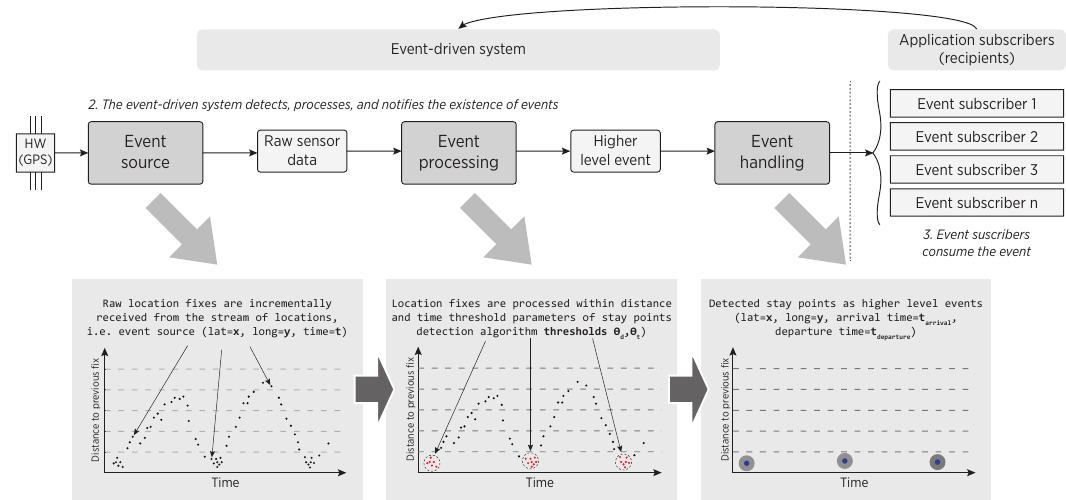
Figure 2. Top-level architecture of an event-driven system in the context of stay points